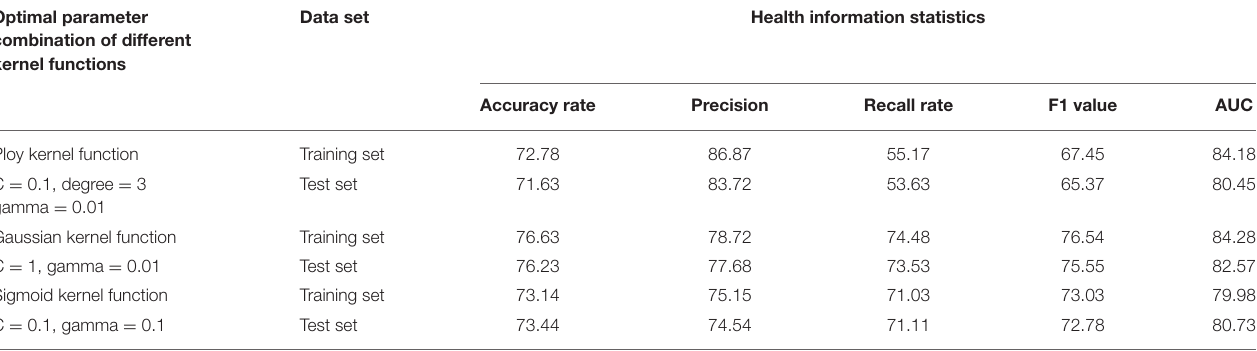
TABLE 6 | Modeling results of different kernel functions of SVM under machine learning combined data. Optimal parameter combination of different kernel